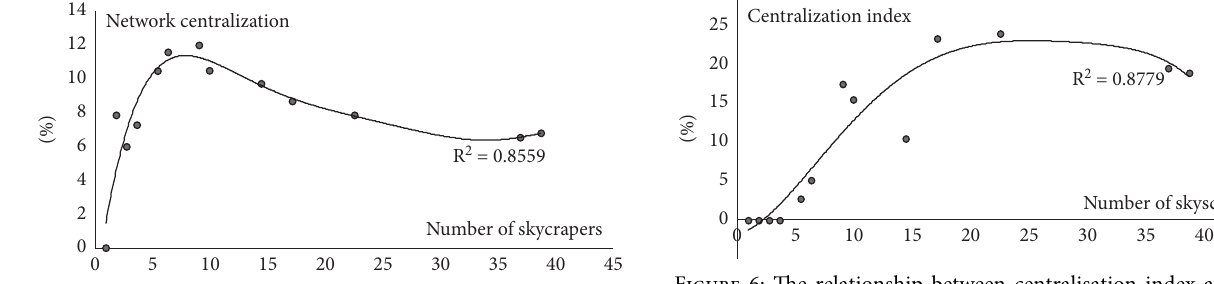
Figure 5: The relationship between network centralisation and the number of skyscrapers.